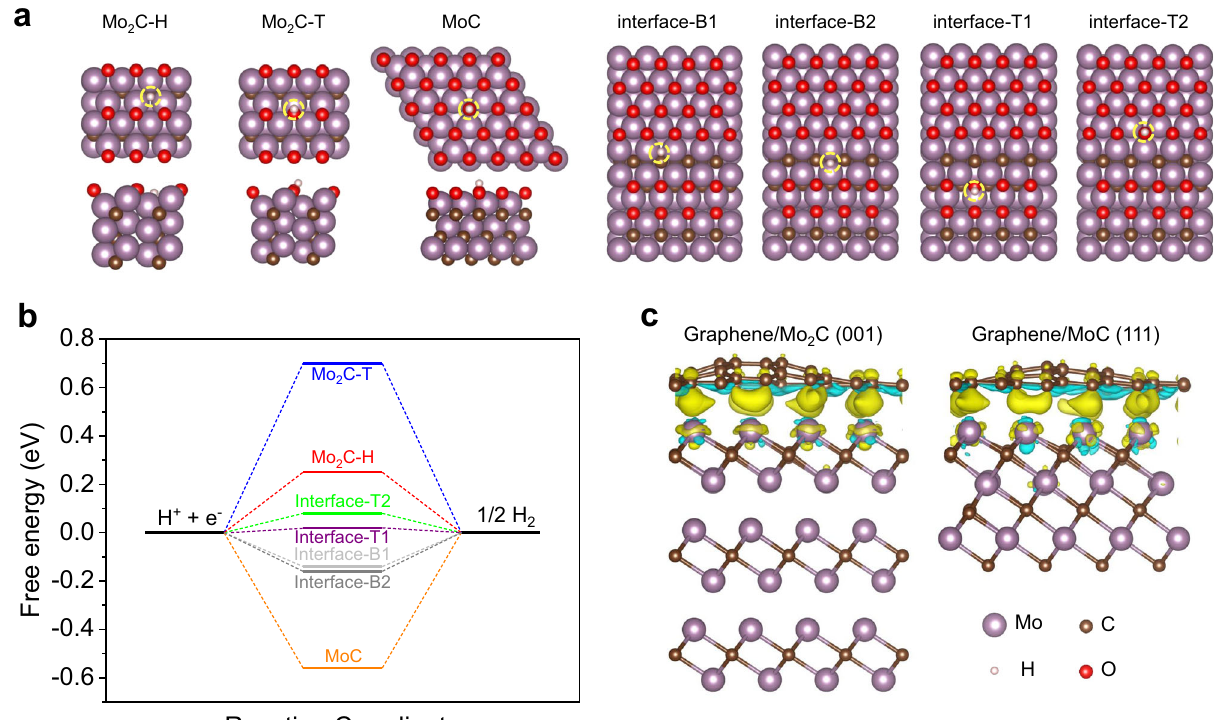
Fig. 5 DFT calculations. a Adsorption structures of hydrogen on the Mo 2 C (100), MoC (111) surfaces, and Mo 2 C (100)/MoC (111) heterostructure, in which the adsorption sites of hydrogen are shown in the yellow dotted circle. The cyan, brown, red and white spheres present the Mo, C, O, and H atoms, respectively (B: bridge site; T: top site; H: hollow site). b Free energy diagram of the HER for different adsorption sites on Mo 2 C (100), MoC (111), and Mo 2 C (100)/MoC (111) heterostructure. c Charge density difference of graphene/Mo 2 C (001) and graphene/MoC (111) heterostructure. The cyan and yellow regions represent charge depletion and accumulation, respectively, and the isosurface value is 0.005 e/Bohr 3